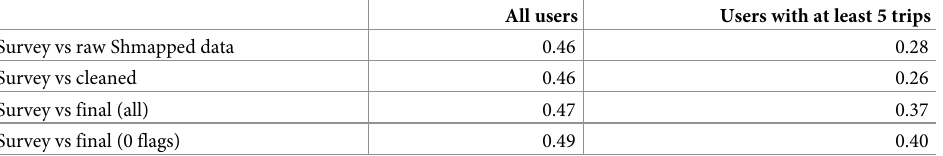
Table 6. Spearman’s rank correlation coefficients of number of respondents to Sheffield City Council Parks and Countryside survey who most frequently visit individual greenspaces, with number of Shmapped users who have visited those